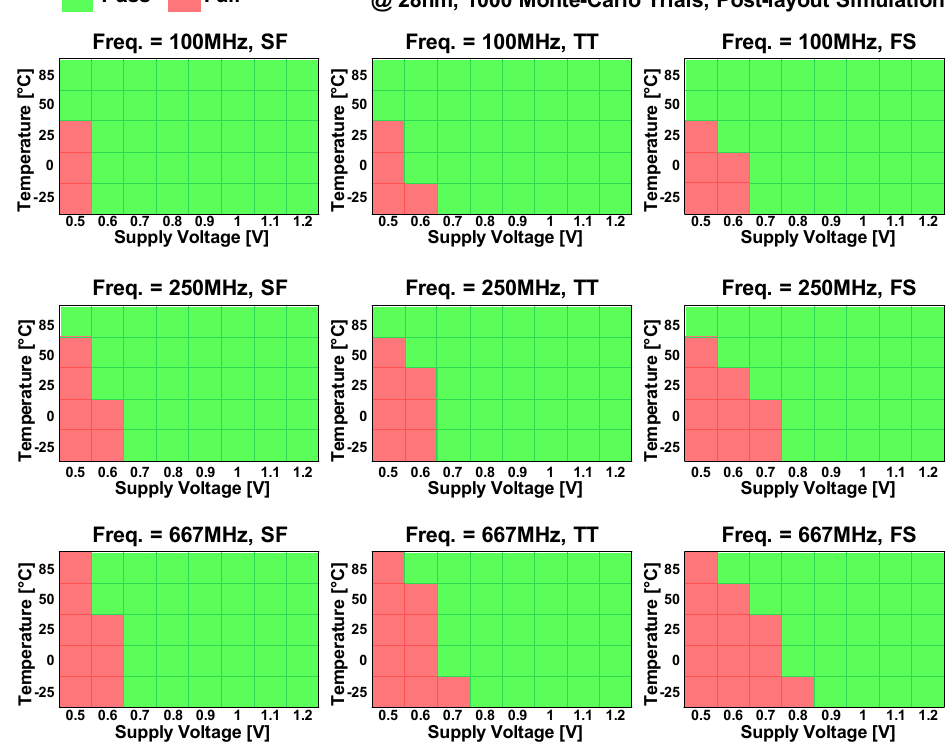
Figure 16. Shmoo plots of post-layout Monte Carlo 1000-trial simulations of the eDRAM with various operating frequencies (100–667 MHz), process corners (SF, TT and FS), temperatures ( − 25 °C to 85 °C) and supply voltages (0.5–1.2 V).